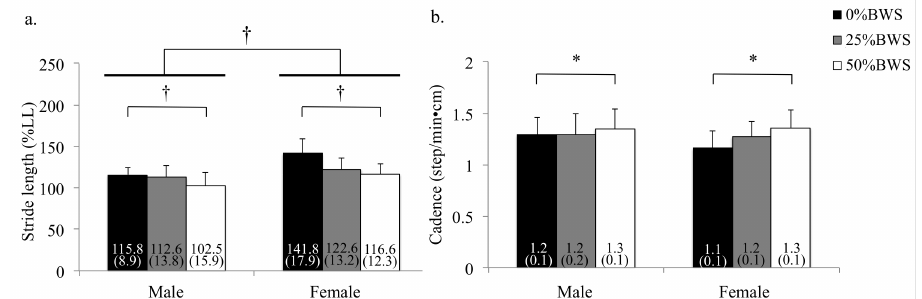
Figure 3. Spatiotemporal gait parameters under 0%, 25% and 50%BWS conditions for male and female participants (( a ) stride length, ( b ) cadence). Data were reported as mean (standard deviation). * p < 0.05, † p < 0.01, BW: body weight, LL: leg length.